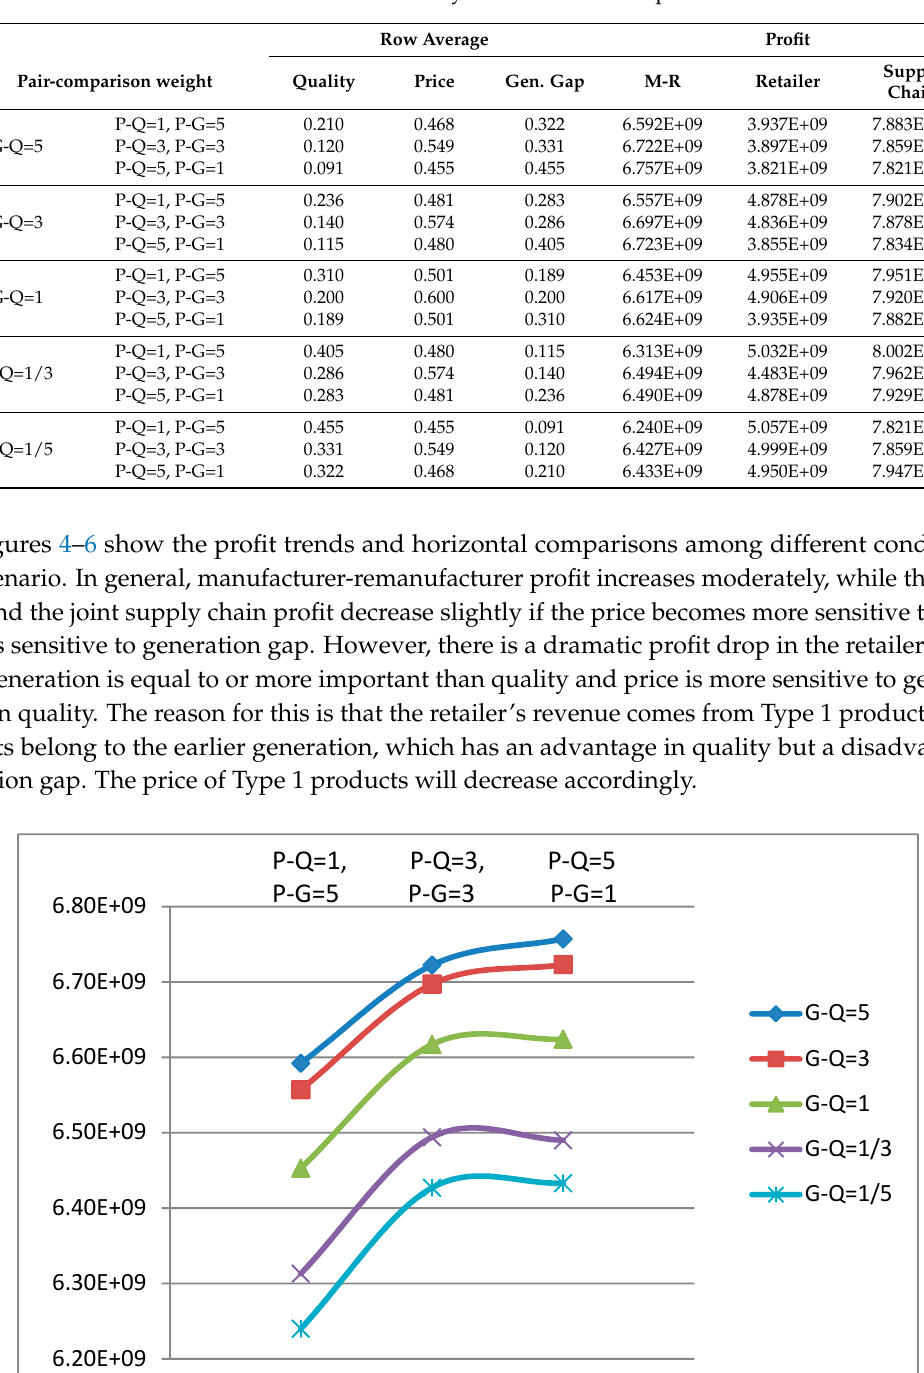
Table 8. Dataset for the analysis of customers’ expectations.